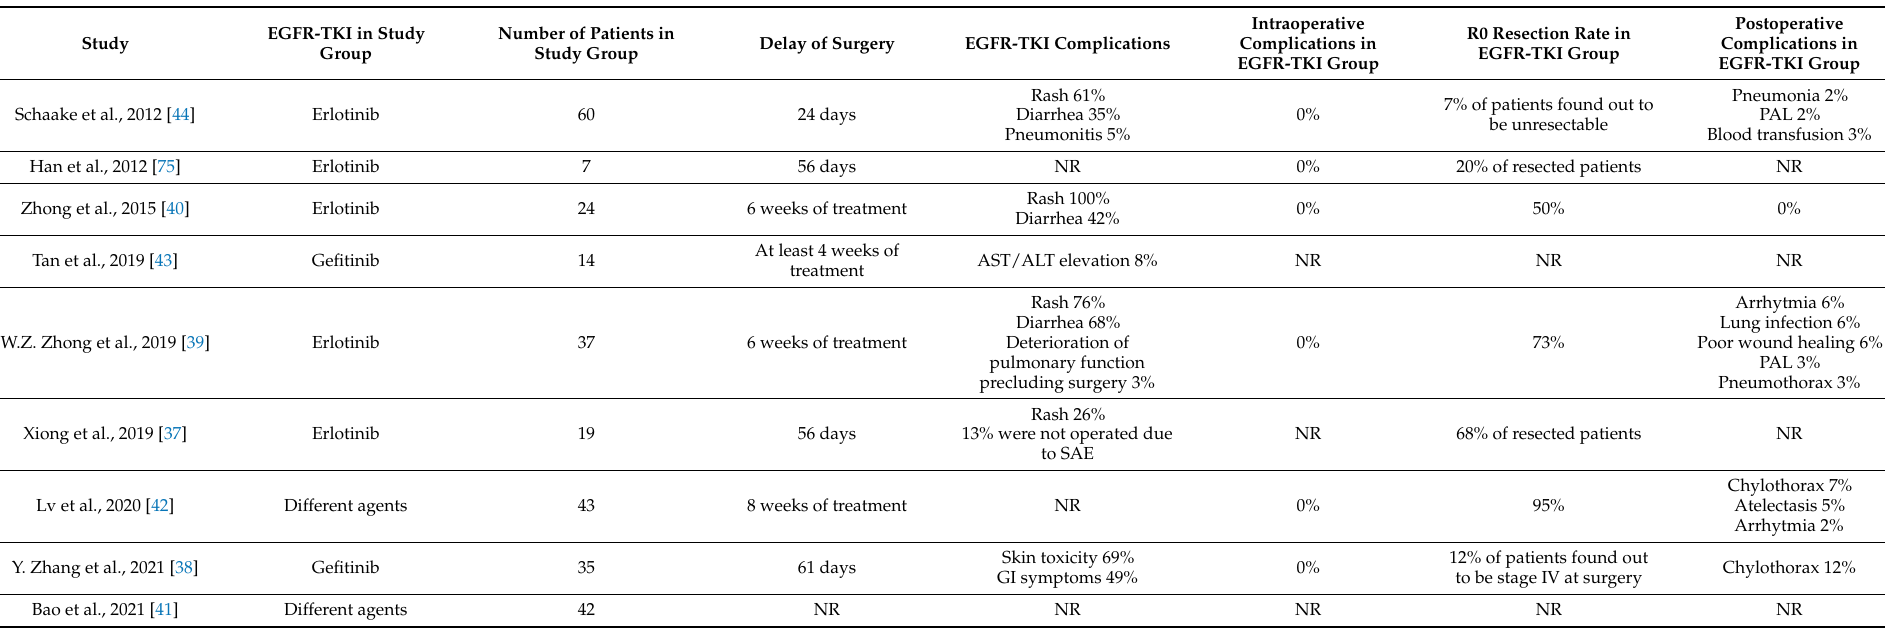
Table 1. Toxicities of neoadjuvant EGFR-TKIs described in the literature. SAE, serious adverse event; EGFR-TKI, epidermal growth factor receptor tyrosine kinase inhibitor; NR, not reported; PAL, persistent air leak; GI, gastrointestinal; ALT, Alanine aminotransferase; AST, Aspartate